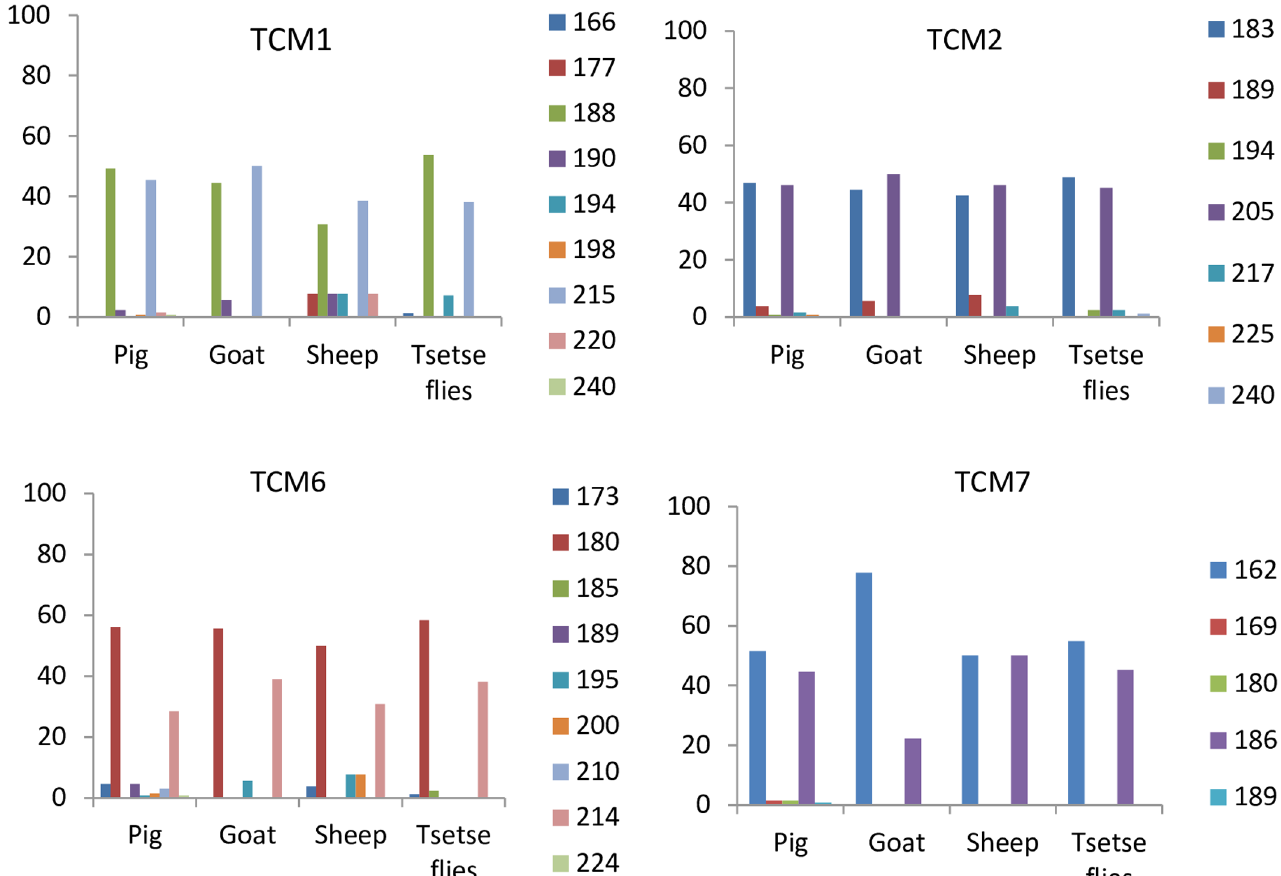
Figure 1. Allelic frequency at each locus by